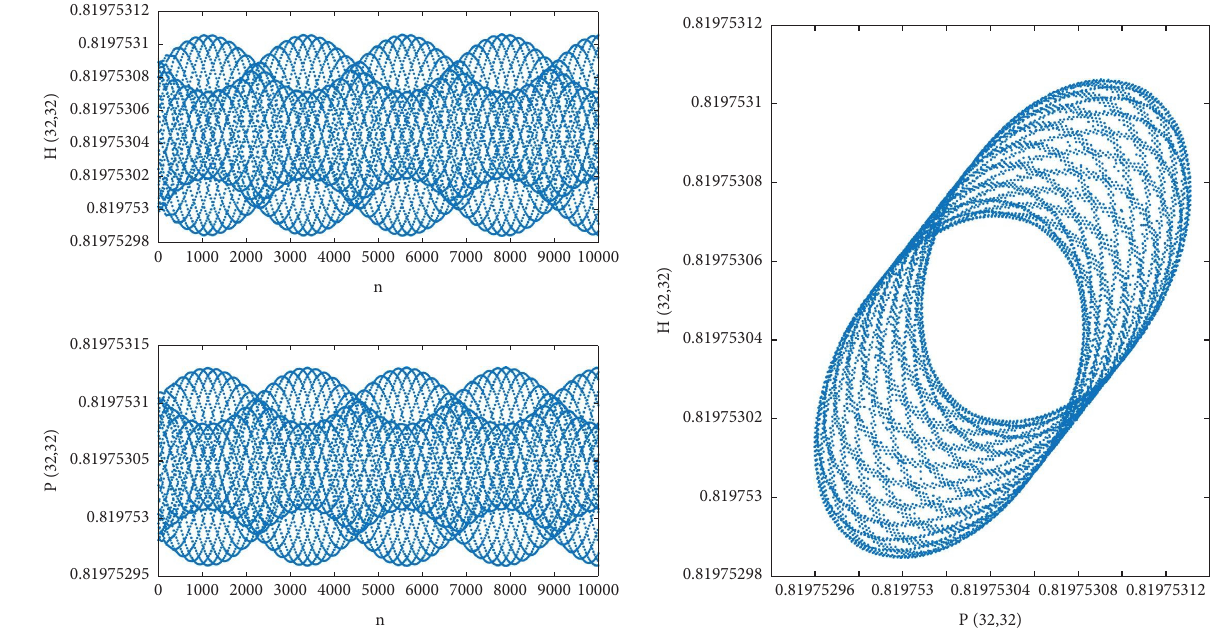
Figure 27: R � 2 ,k � 1, c � 0 . 8, σ ∗ � 0 . 278655, σ � σ ∗ , ( d Figure 9(b), which is consistent with the case of Corollary 3(9), a Neimark-Sacker-Flip-Flip bifurcation occurs, the number of parasites and hosts is very complex and can be regarded as a chaotic